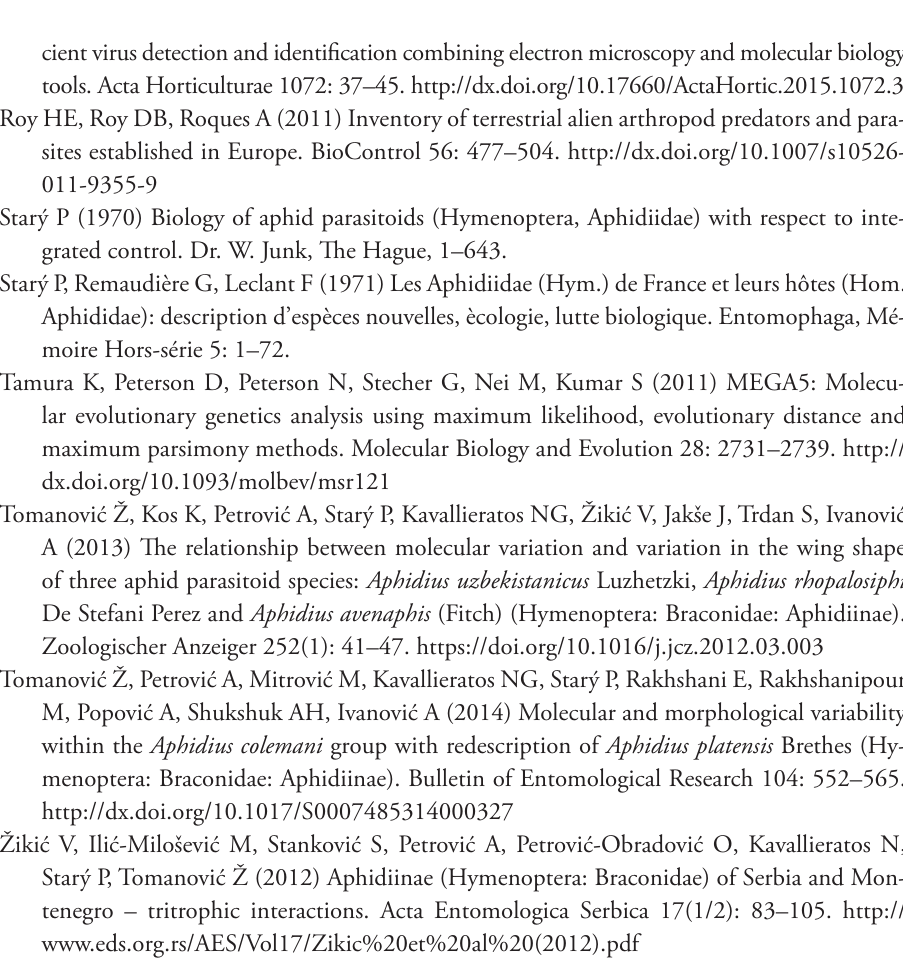
Table S1. Parasitoids of Ericaphis aphids from North America and Europe Authors: Andjeljko Petrović, Jelisaveta Čkrkić, Aiman Jamhour, Olivera Petrović- Obradović, Milana Mitrović, Petr Starý, Barbro Nedstam, Željko Tomanović Data type: species